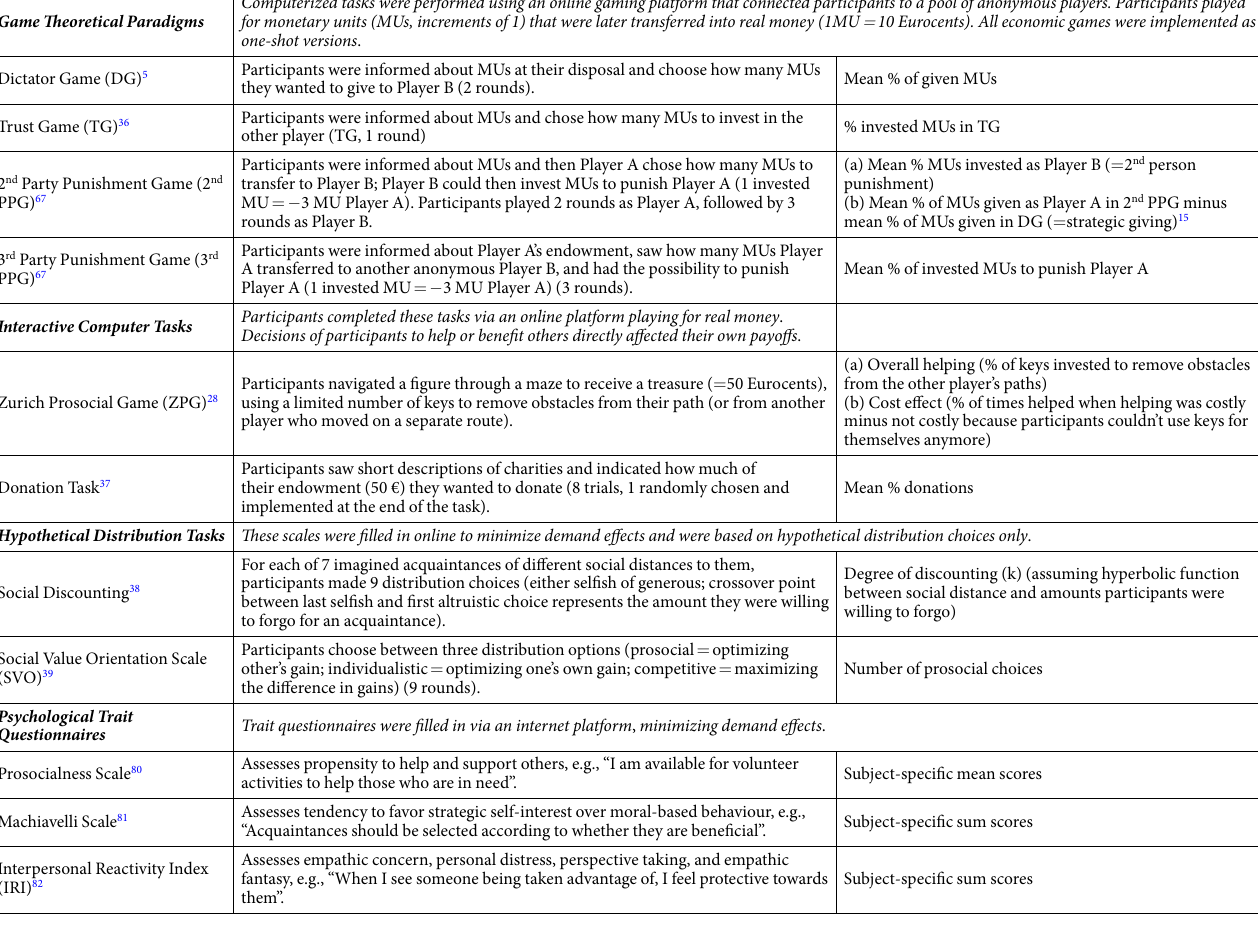
Table 1. Short description of included measures of